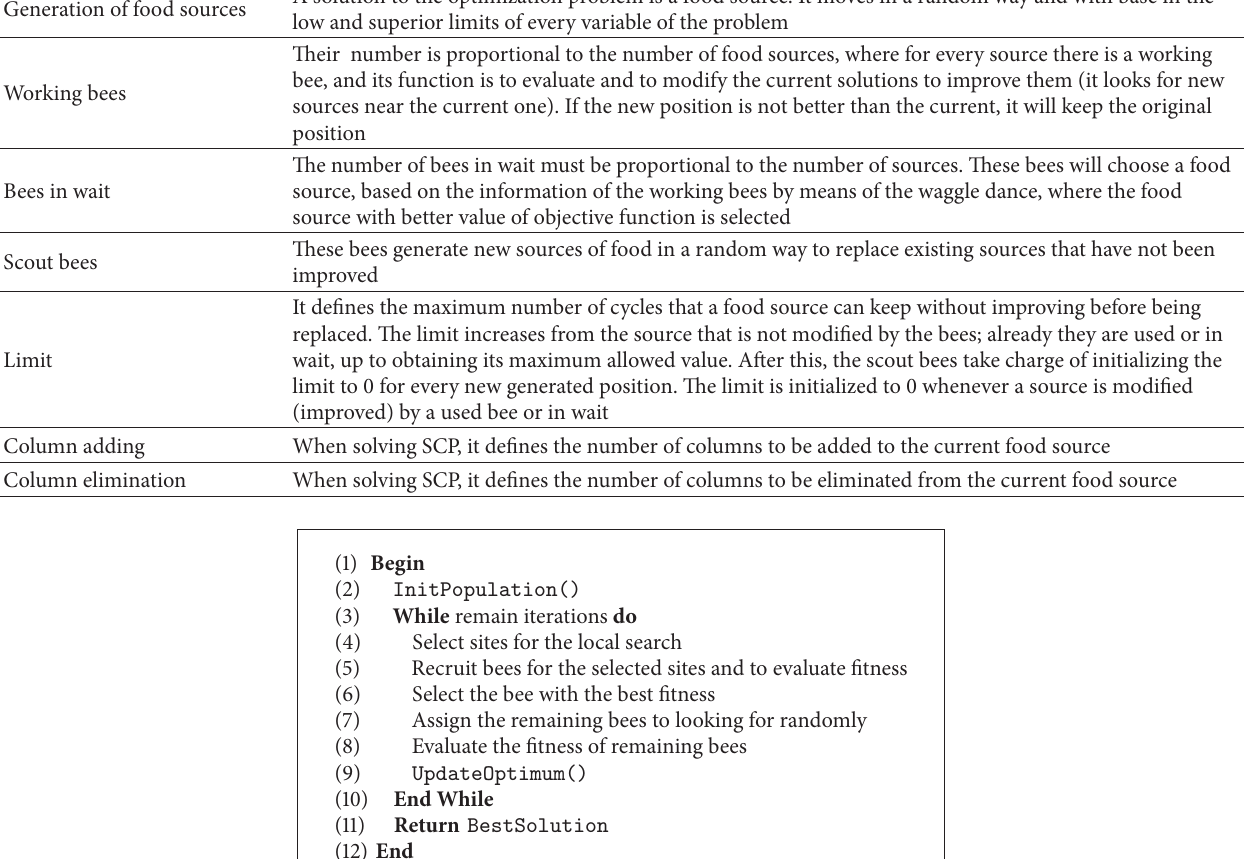
Table 2: Summary of ABC main